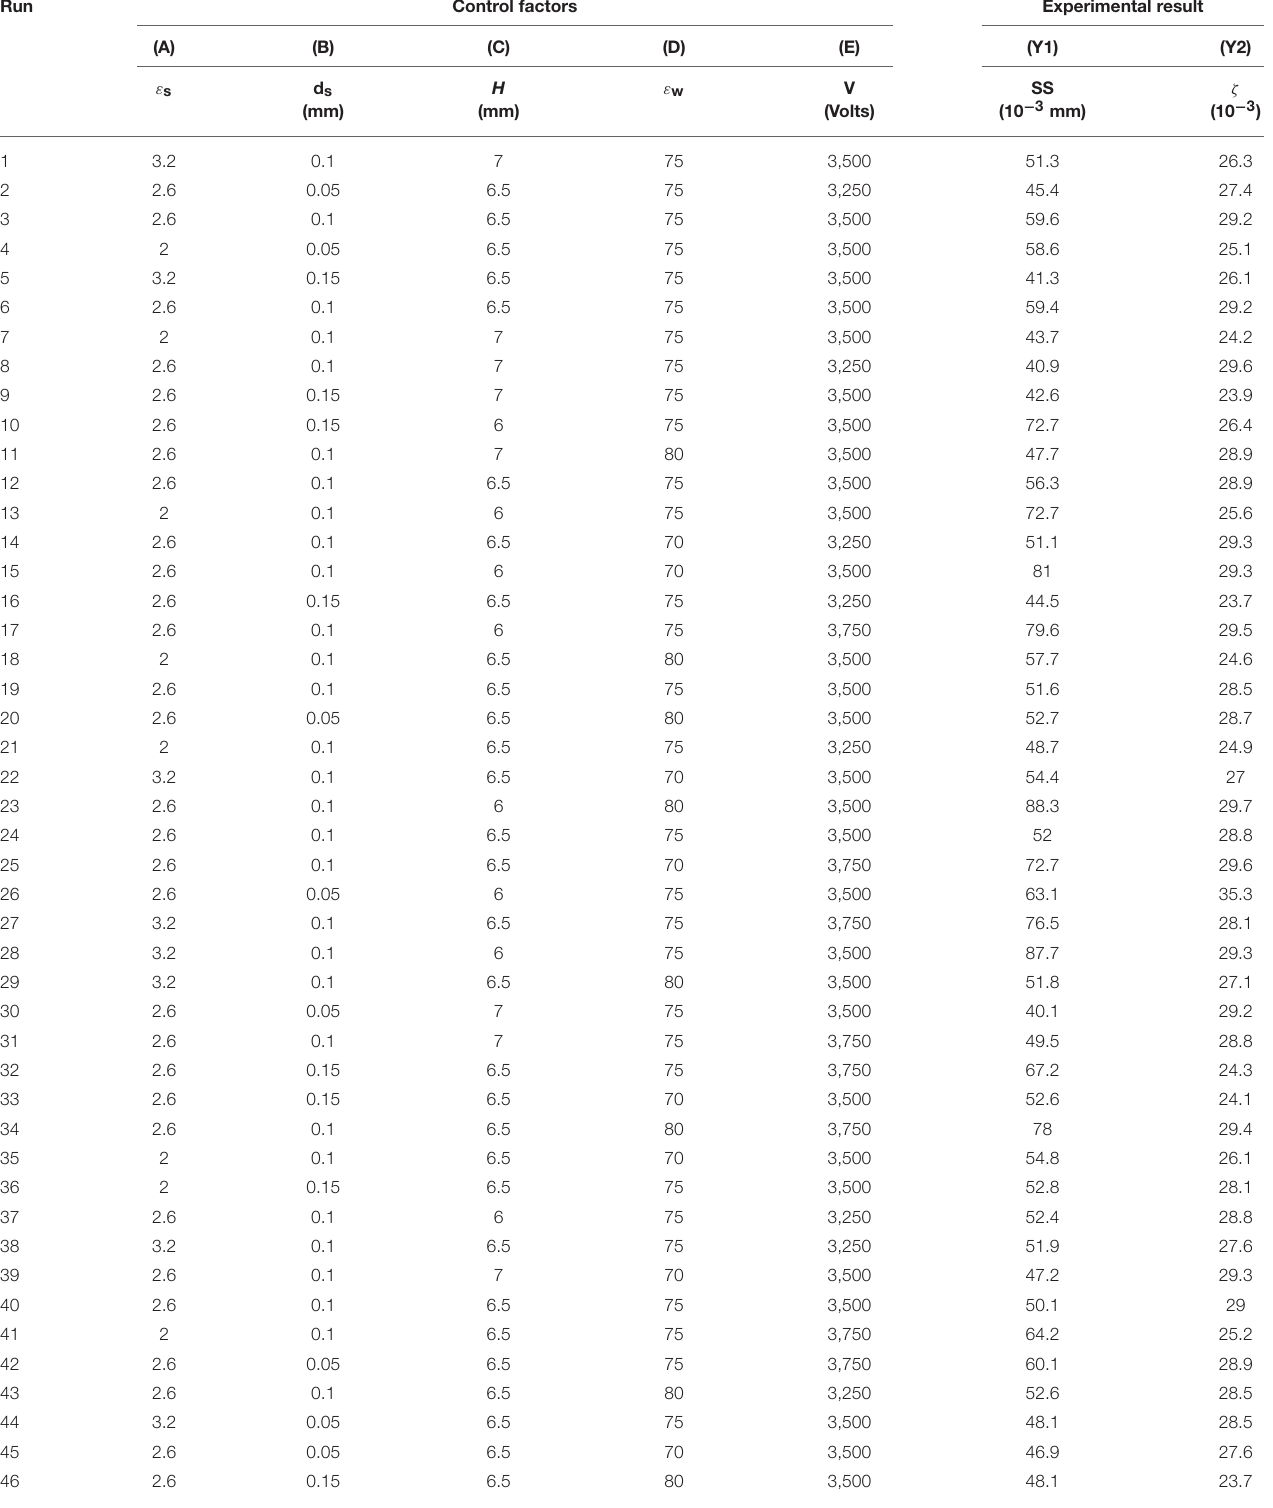
TABLE 2 | Details of DOE using RSM with experimental